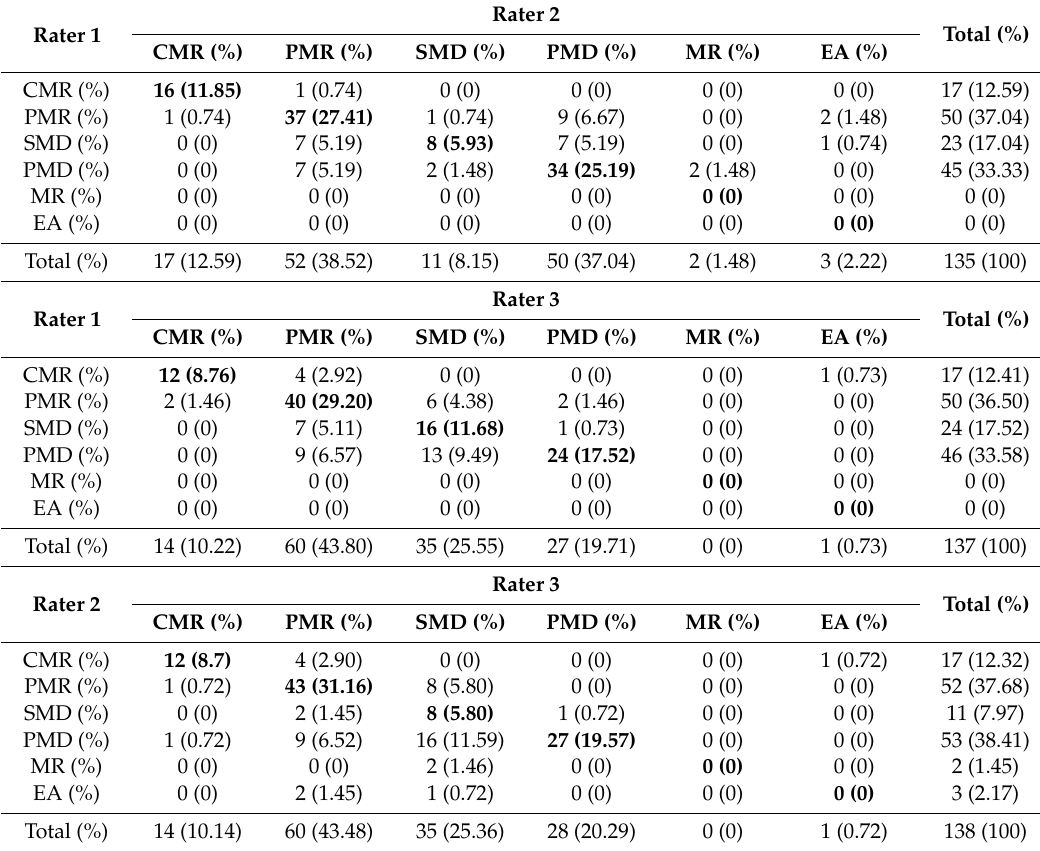
Table 2. Interrater response assessment using visual